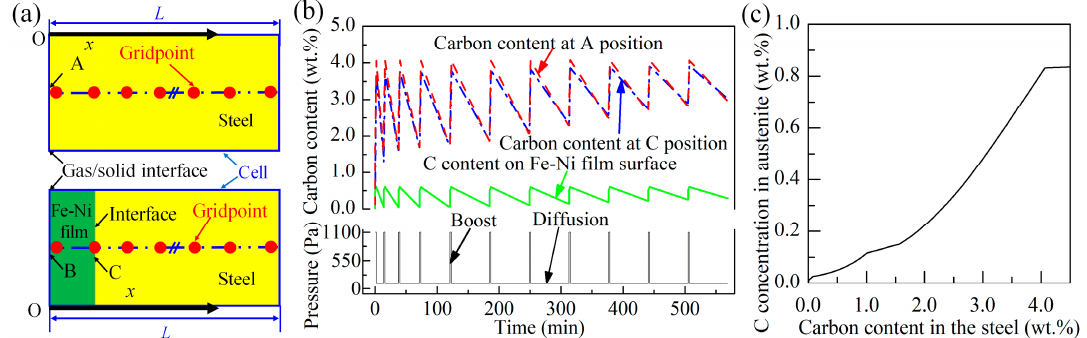
Figure 1. ( a ) Geometrical models showing the unit cell implemented for the low-pressure carborizing (LPC) simulation, the upper model for uncoated sample, and the lower model for Fe–Ni coated sample; ( b ) simulated C content as a function of LPC time at different positions marked on ( a ); and ( c ) carbon concentration in austenite as a function of total carbon content in the 14Cr14Co13Mo4 steel at 890 °C calculated by Thermo-calc software.